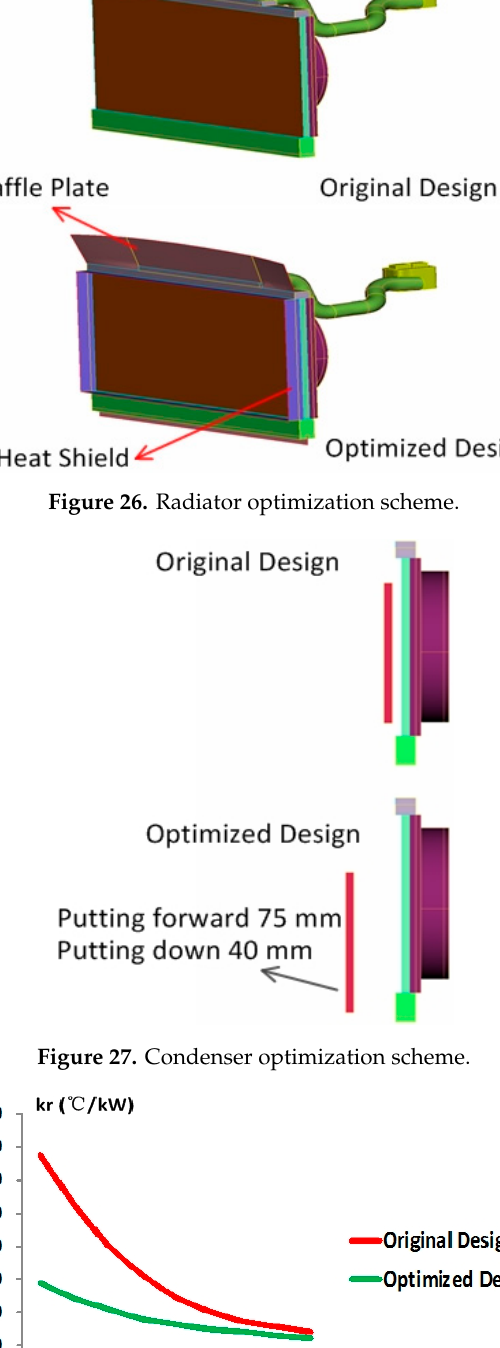
Figure 27. Condenser optimization scheme.